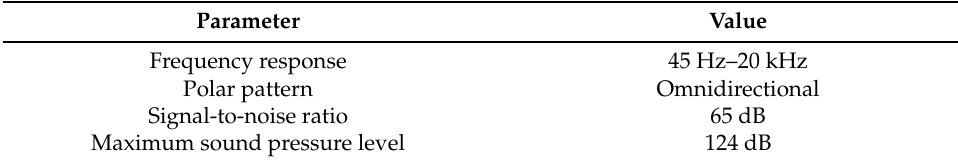
Table 1. Voice sensor parameters.